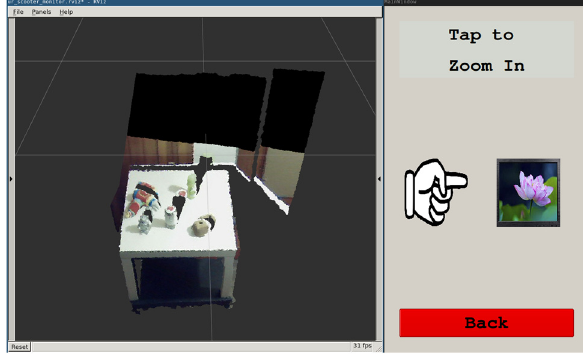
Figure 7: The GUI is showing the selected object in green, and asking the user to con fi rm that the correct object is selected. This is the Con fi rmation state in Figure 3.